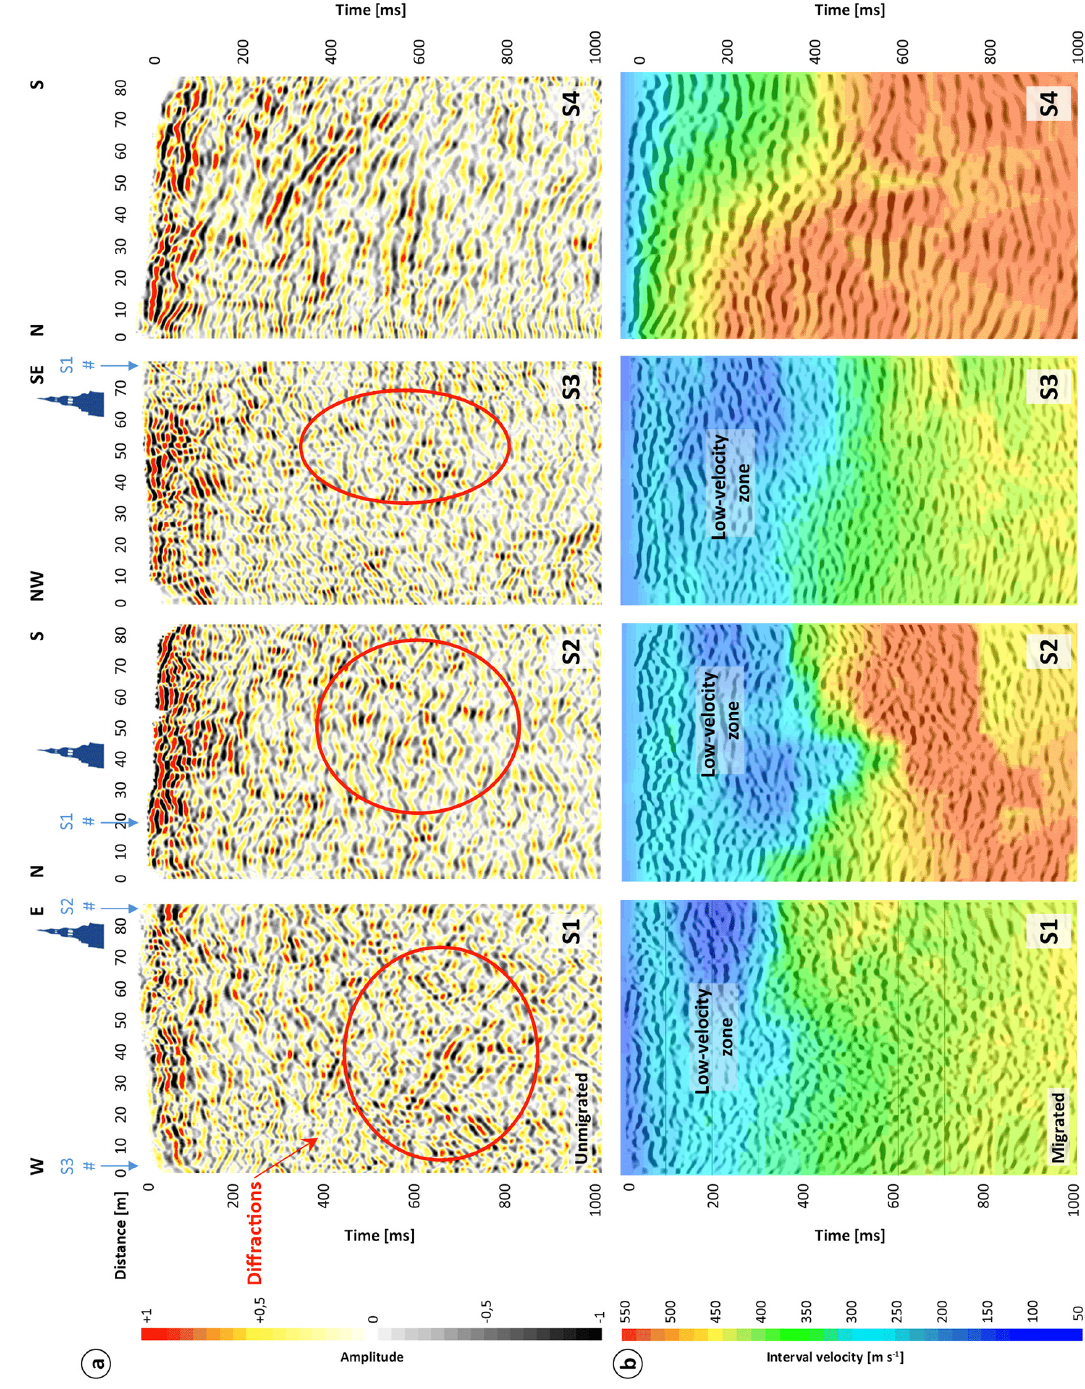
Figure 10. Shear-wave seismic reflection profiles S1–S4 with (a) stack in time domain showing diffractions and color-coded amplitudes and (b) FD migration in time domain with color-coded interval velocities. Position of the church tower is marked, blue arrows represent intersection points of profiles and red circles reveal areas with